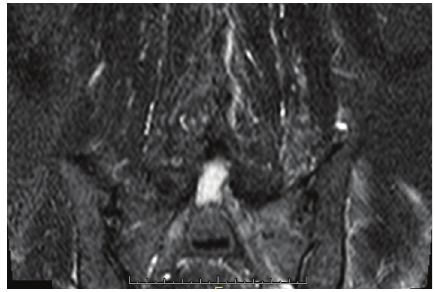
Figure 2: MRI with osteomyelitis of the sacrum as well as free air bubbles in the